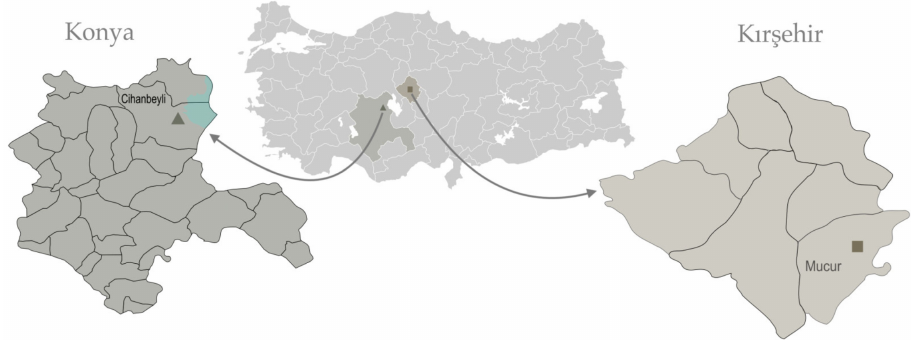
Figure 5. Distribution of Ferula turcica (Konya) and F. latialata (Kır¸sehir). Conservation status: Ferula turcica , a halophyte, grows in rare habitats. Salt is